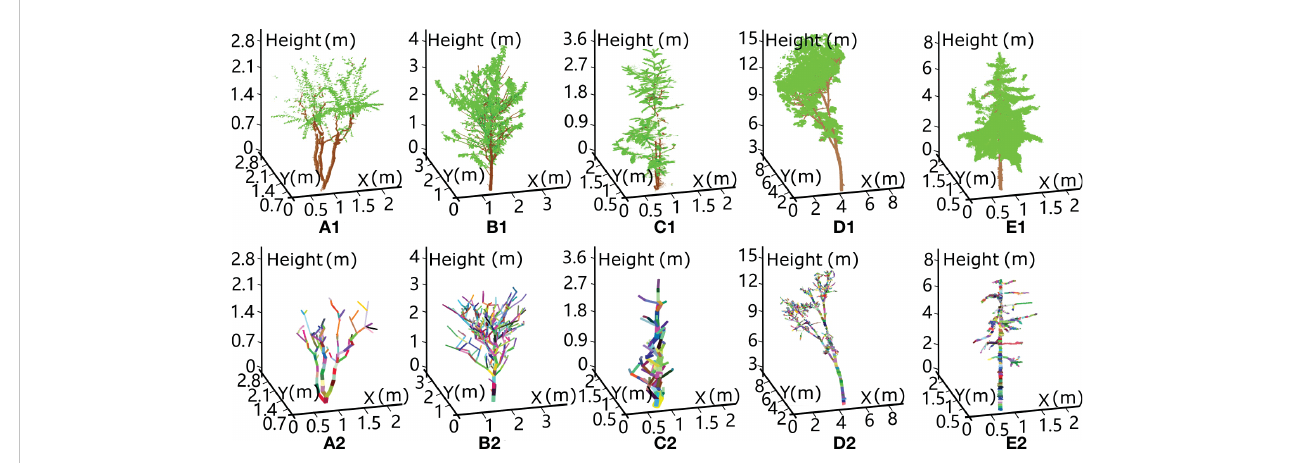
FIGURE 1 Schematic diagram showing wood – leaf separation and branch skeleton reconstruction from terrestrial laser scanning data for fi ve experimental trees: A (A) crepe myrtle tree, (B) sakura tree, (C) magnolia tree, (D) rubber tree and (E) ginkgo tree. The fi rst row lists the classi fi ed leaf and branch points represented in green and brown, respectively. The second row shows the reconstruction results of the branch segments based on the cylinder model fi tting